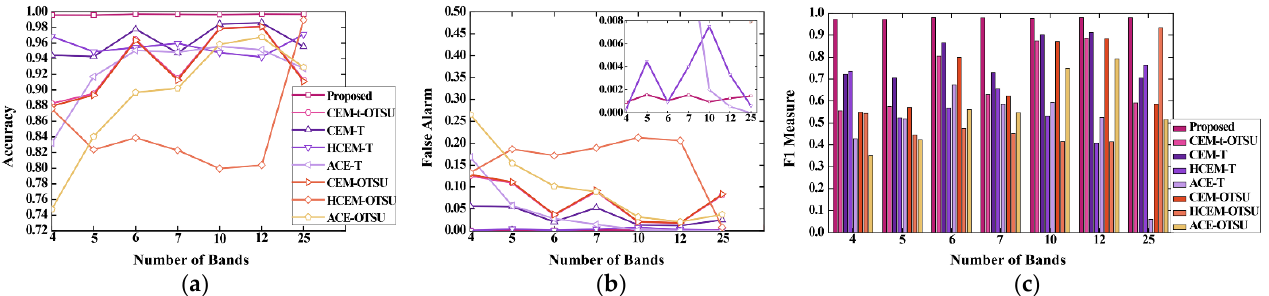
Figure 18. The quantitative comparison of ASRC-net detection results in the BF scene at 35 mm focal length; ( a ) The curves of A C obtained using different methods; ( b ) The curves of F a obtained using different methods; ( c ) The histograms of F 1 obtained using different methods.